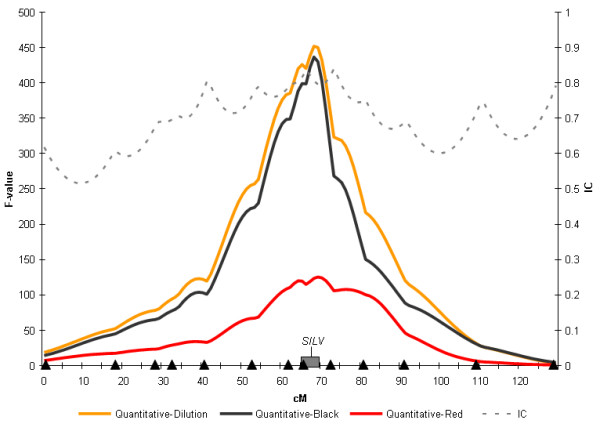
Linkage evidence on bovine chromosome 5 for the locus affecting the eumelanin and phaeomelanin dilution in Charolais crosses. F-ratio profile obtained for the dilution-related traits Quantitative-dilution, Quantitative-Black and Quantitative-Red on chromosome 5. Dashed lines indicate information content (right y-axis). Marker positions are identified as triangles above the x-axis. The peak of the statistical profiles was flanked in all the cases by markers ETH10 and DIK5248. The bootstrap 95% CI for Quantitative-Black is indicated as a grey box above the x-axis. The position of the SILV gene according to our linkage analysis is represented on the x-axis.